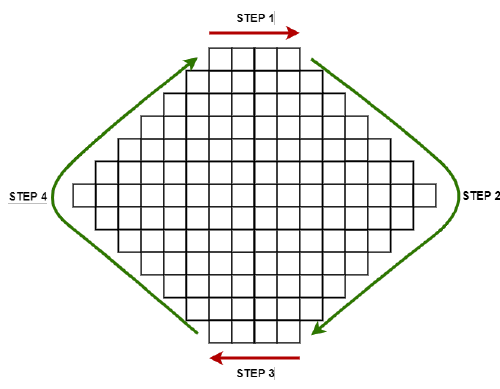
Figure 16. Steps to order values of distances to center. The overall process is described in Figure 17.